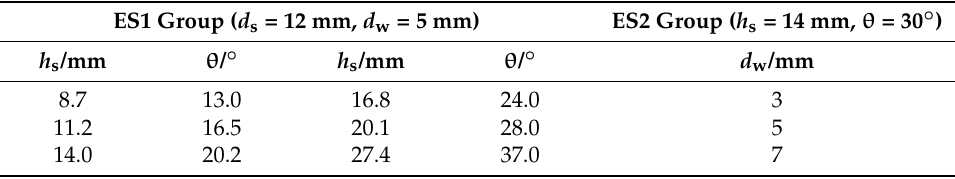
Table 1. Structure parameters of the spiral grain selectors in the experiment.